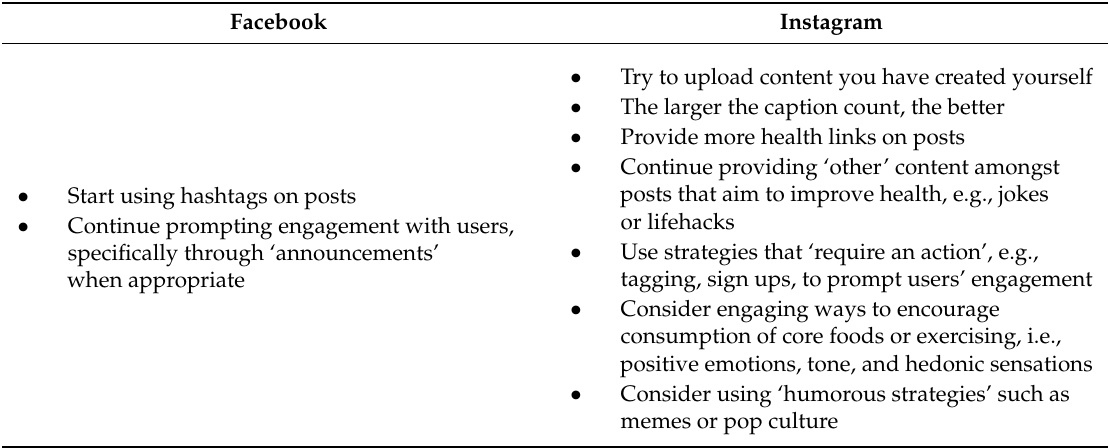
Table 3. Recommendations for health promoters based on strategies used and strategies associated with higher